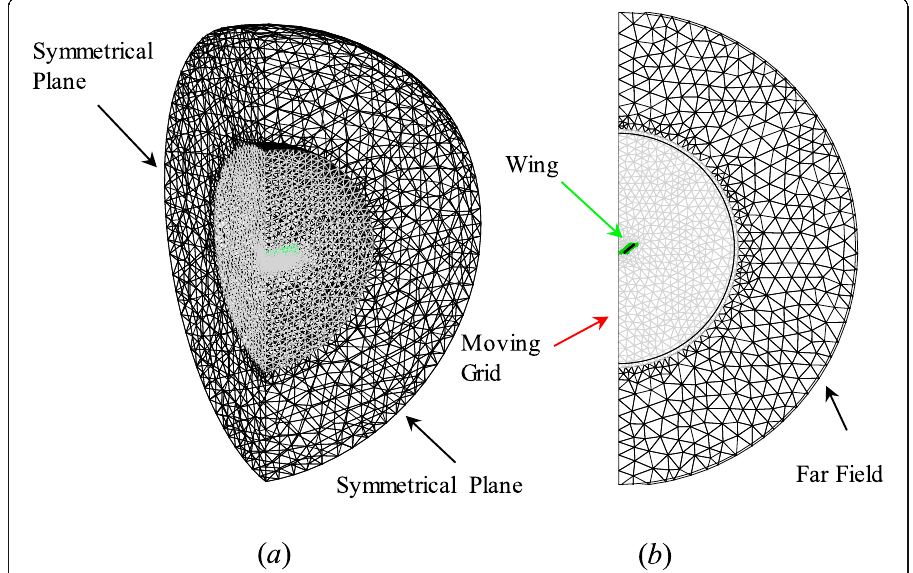
Fig. 4 Mesh used for CFD simulation ( a ) Computational domain mesh, ( b ) Side view of computational